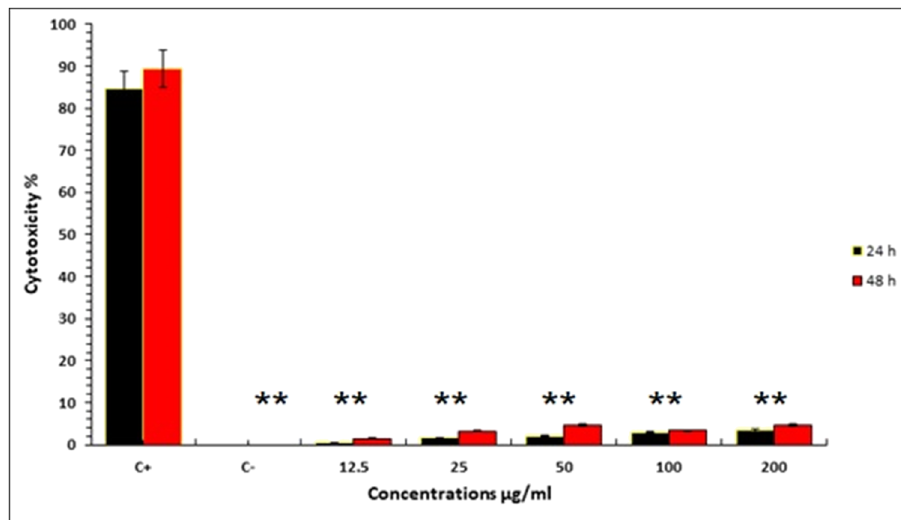
Figure 7: Cytotoxic e ff ect of green - synthesized IONPs on Vero cells after exposure to di ff erent concentrations for 24 and 48 h compared to negative and positive control. Error bars represent mean ± SD; * mean highly signi fi cant di ff erence p <